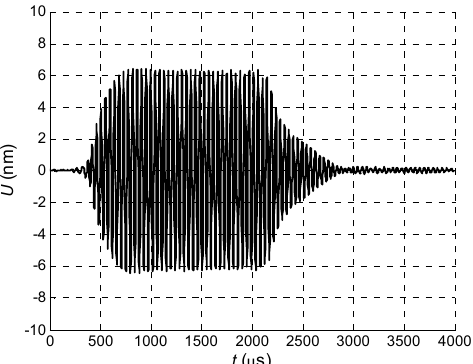
Figure 27. Normal displacement signal U of the clear PVC film, measured at L = 1 mm, when all array elements are excited using delay scheme with equal Δ t = 50.4 µs step.